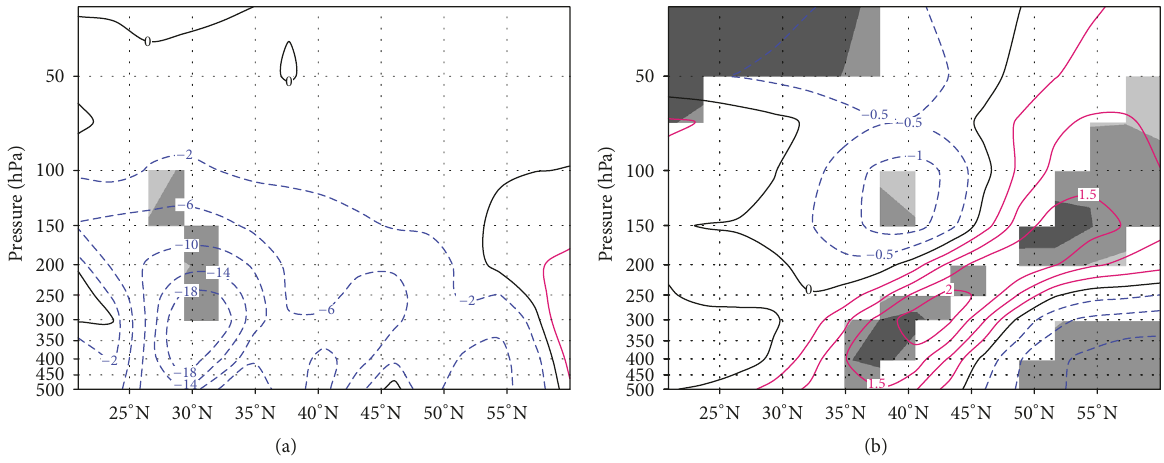
Figure 4: The same as Figure 2, but for vertical velocity ((a), units: 10 −3 Pa/s) and for zonal deviation of temperature ((b), units: K).